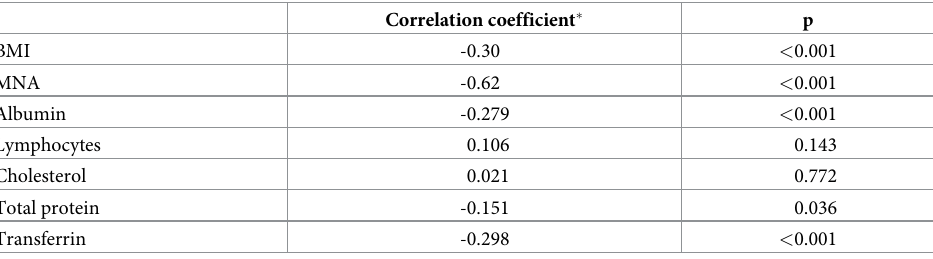
Table 6. Correlation between EdFED (Nurses) and BMI, MNA and biochemical parameters n = 196. Correlation coefficient